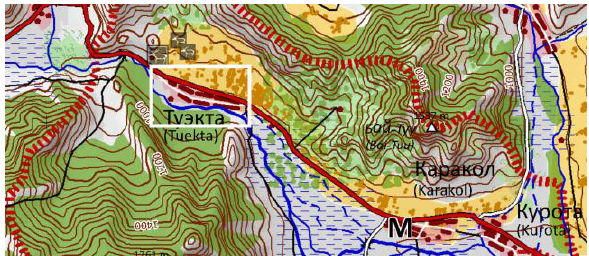
Figure 1: Map derived from the “ALTAI 100” GIS contents.